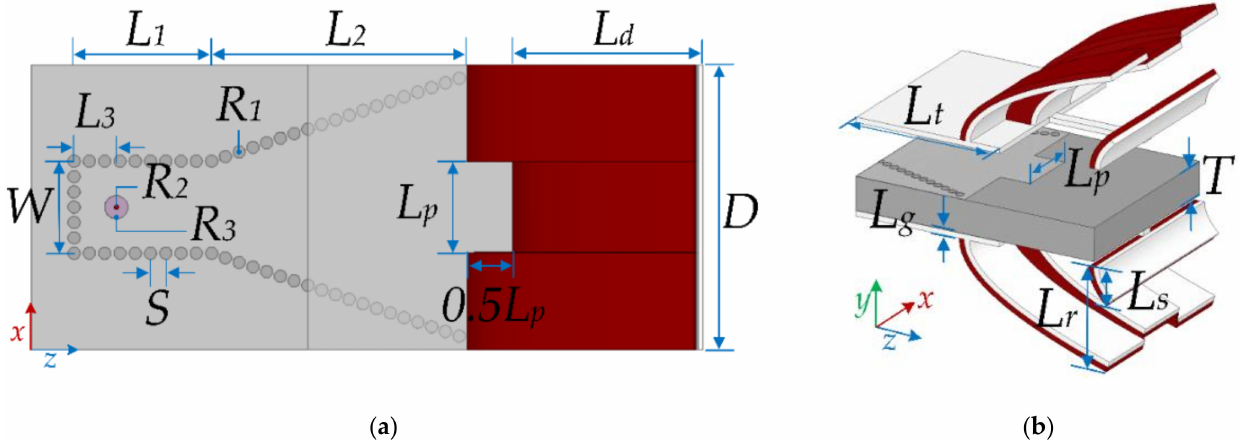
Figure 2. The proposed SIW horn antenna geometry with labeled parameters. ( a ) Top view; ( b ) perspective view of the parasitic E-plane horn. Table 1. Dimensions of the proposed antenna (values are in millimeters). Antenna